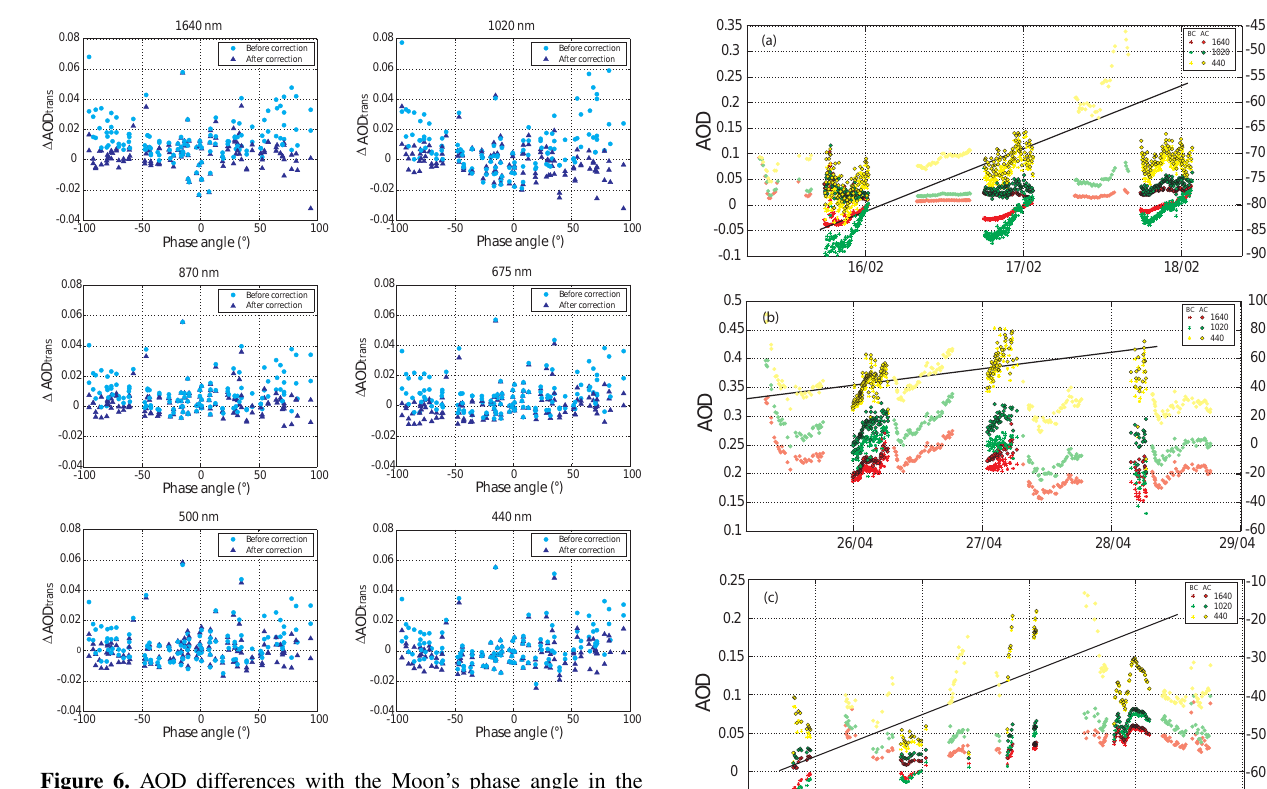
Figure 6. AOD differences with the Moon’s phase angle in the AOD day–night transition coherence test between daytime CE318- N AERONET AOD and CE318-T nighttime AOD during sunset– moonrise and moonset–sunrise period before (circles) and after (tri- angles) the AOD correction.